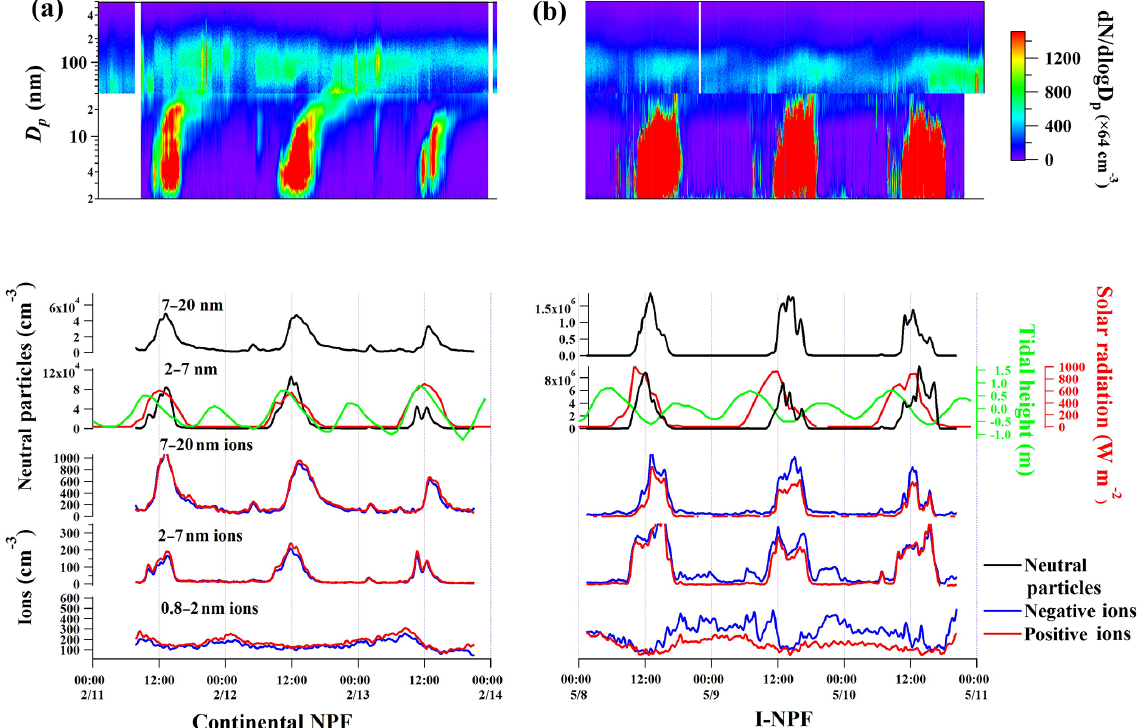
Figure 2. Particle number concentration during (a) the continental NPF days from 11 to 13 February 2018 and (b) the iodine-induced NPF (I- NPF) days from 8 to 11 May 2018. From top to bottom curves: particle size spectra of the NPF events; diurnal variations of 7–20 and 2–7nm neutral particles (black curves); diurnal variations of 7–20, 2–7, and 0.8–2nm negative (blue curves) and positive ions (red curves). Solar radiation and tidal height were obtained from local maritime authority and plotted as red and green curves,